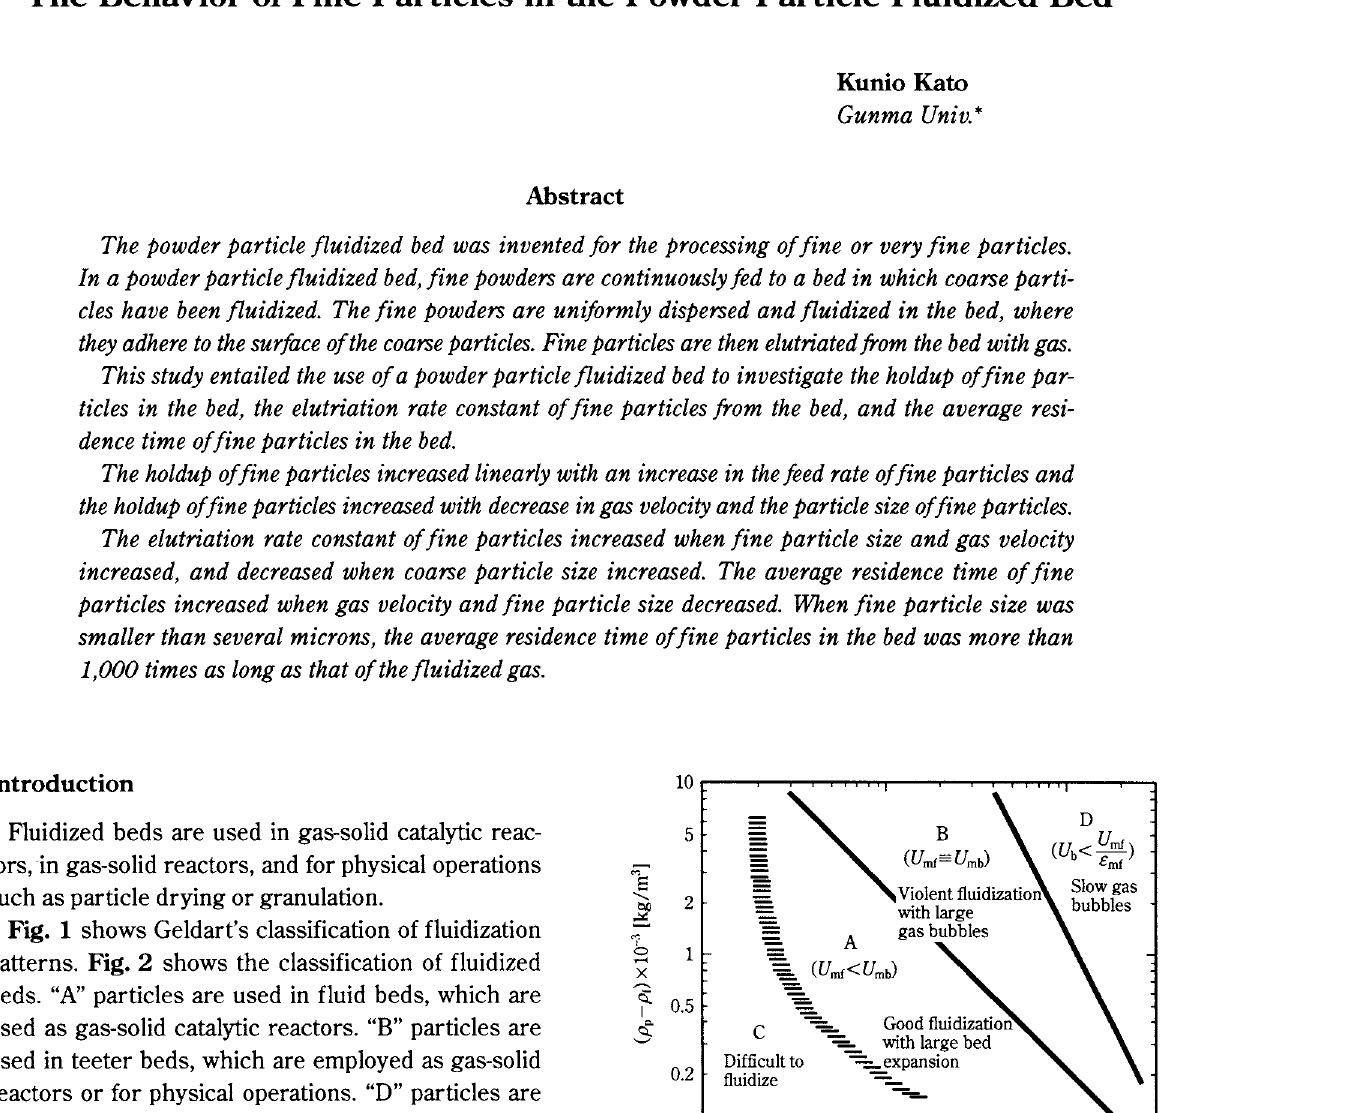
Fig. 1 Relation between fluidization pattern and particle size